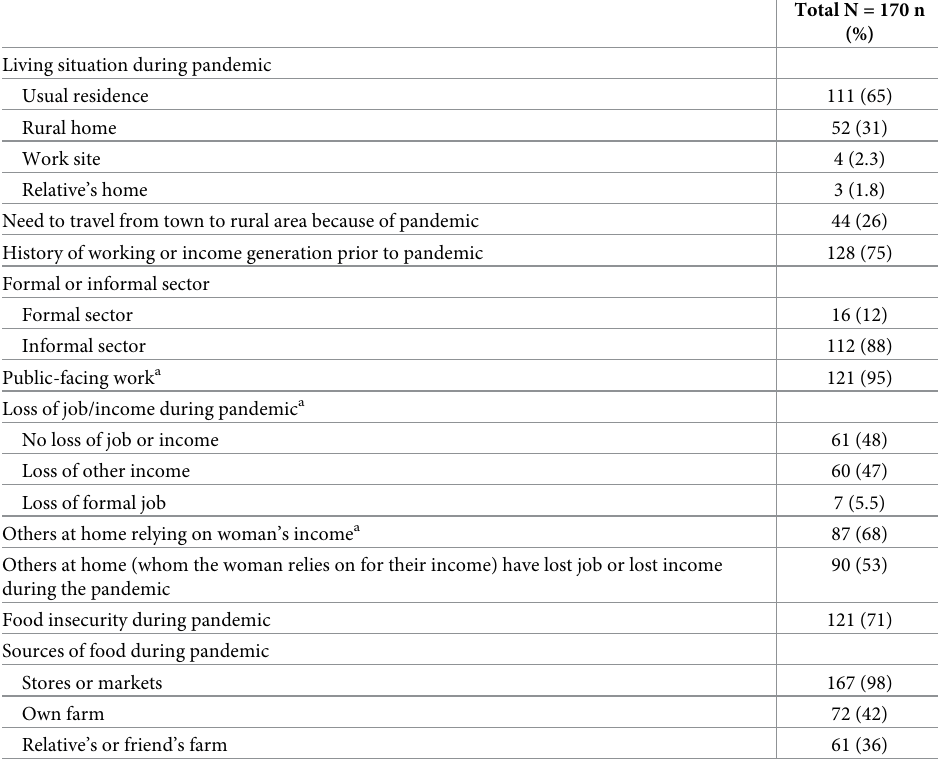
Table 3. Social and economic impacts of the COVID-19 pandemic among late postpartum WHIV.